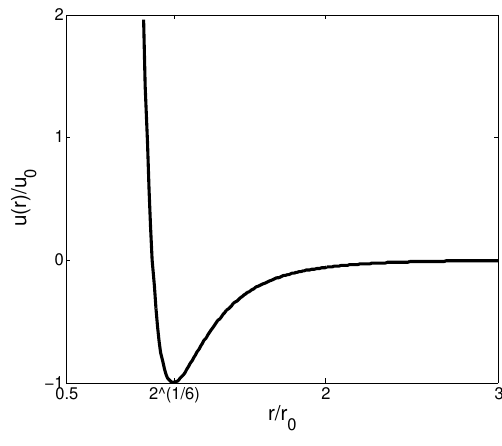
Figure 4 . The Lennard-Jones 12–6